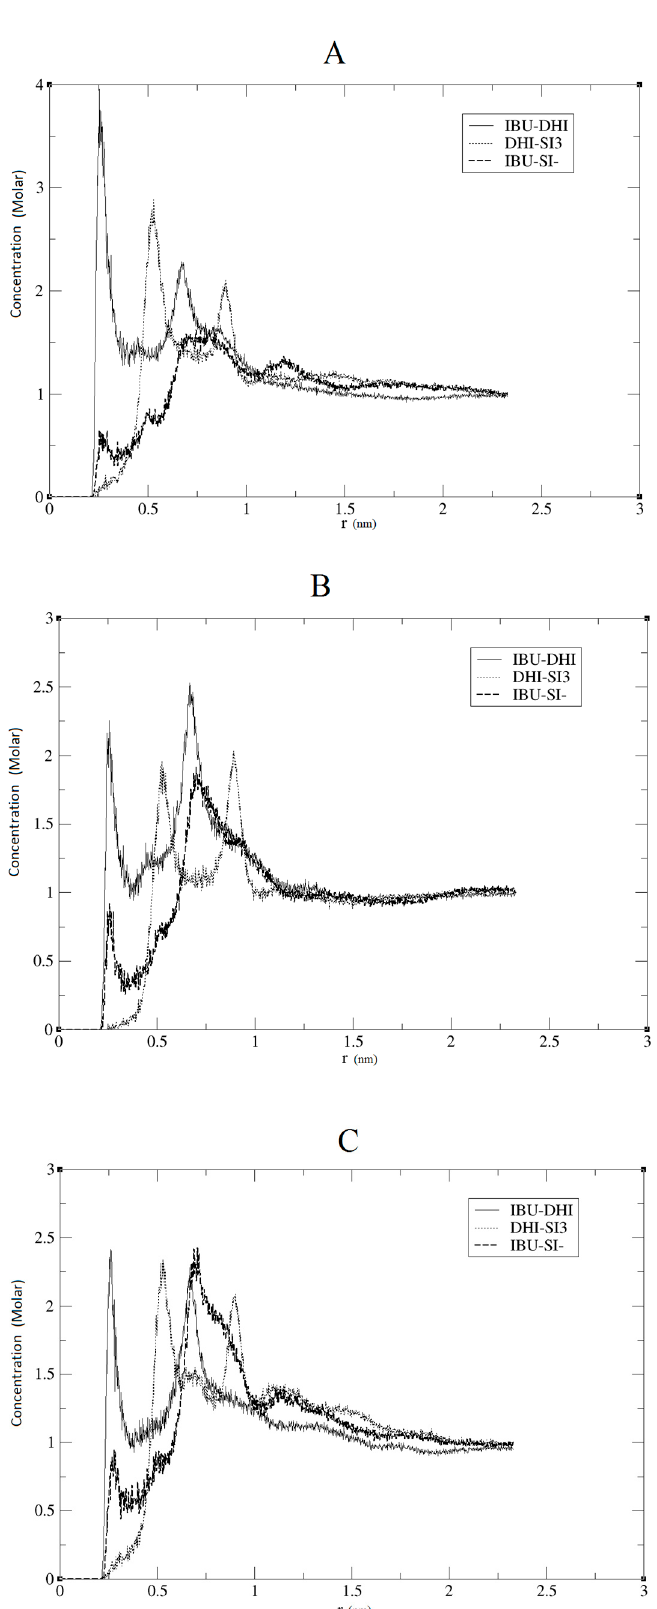
Figure 2. Radial distribution functions (RDF) analysis using the H atom of DHI for the pairs IBU-DHI, DHI-SI3, IBU-SI − . A , B and C represent the RDF of each MD replica.